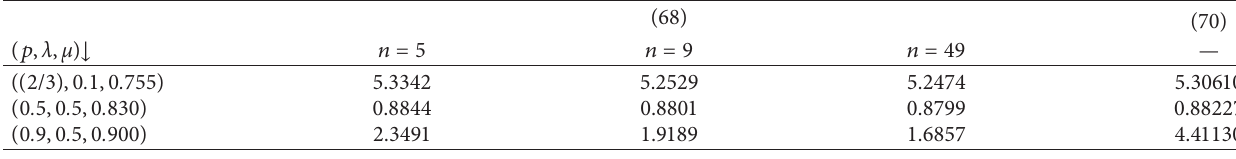
in oscillation 0